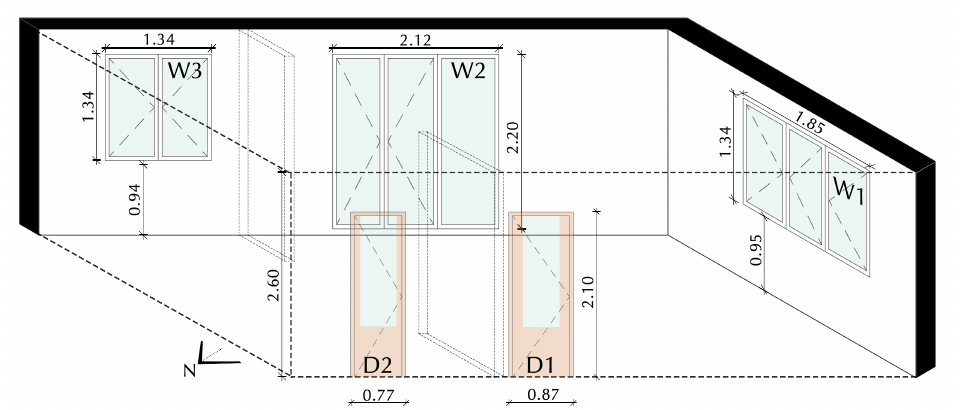
Figure 2. Isometric representation of the five openings of the room. The panels in two interior wooden doors are divided into two parts: The first is glazed with wooden mullions, and the lower part is only made of wood. The main door (D1) is 1.72 m², and the secondary door (D2) is 1.61 m². The southwest façade has a tilt-and-turn window (W1) (2.47 m²), the southeast façade has a door window (W2) with an area of 4.66 m², and a tilt-and-turn window (W3) with an area of 1.79 m². All windows are made of aluminium, double-clear glass of 3 mm each, and an air cavity of 13 mm. See Figure 3 for the plan view.